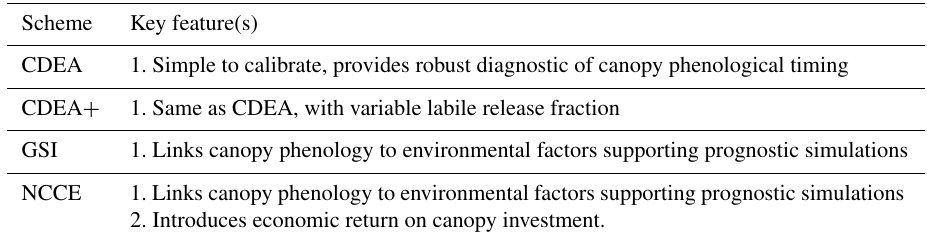
Table A4. Summary of key features for each phenology sub-model. Scheme